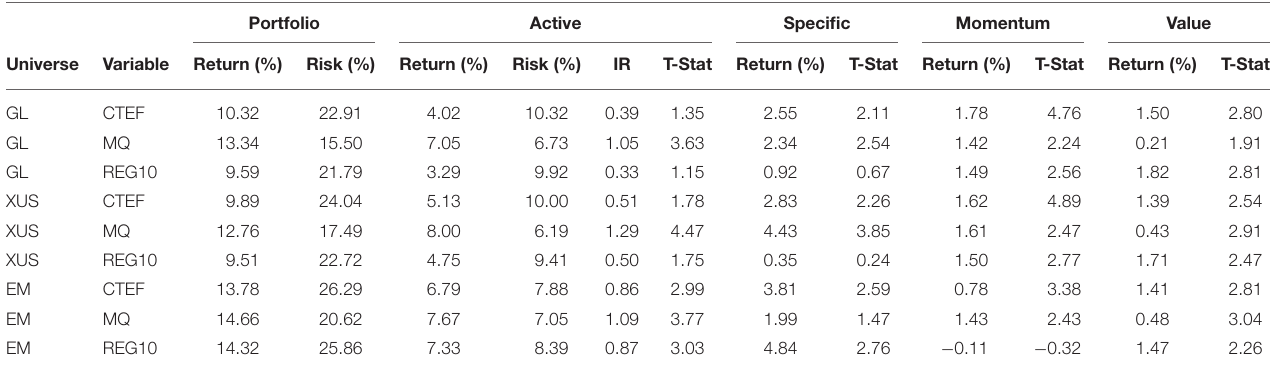
TABLE 1 | Mean-ETL portfolio